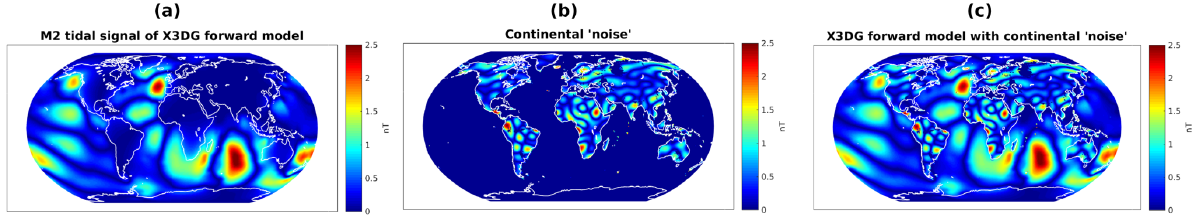
Figure 8. Absolute value of the radial part of B X3DG oc (a) and model of continental “noise” e (b) , as well as superposition B e oc of both of these (c)